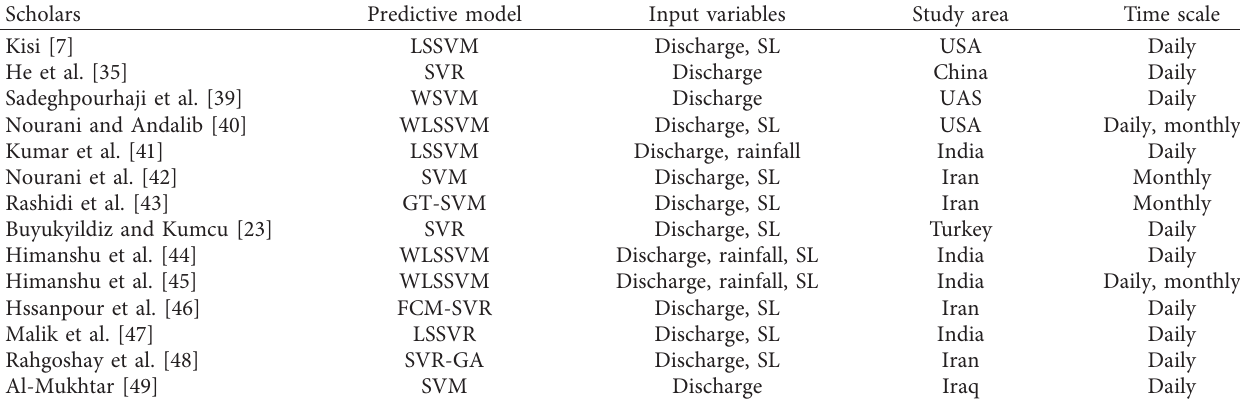
Table 1: The summary of support vector machine models for predicting suspended sediment